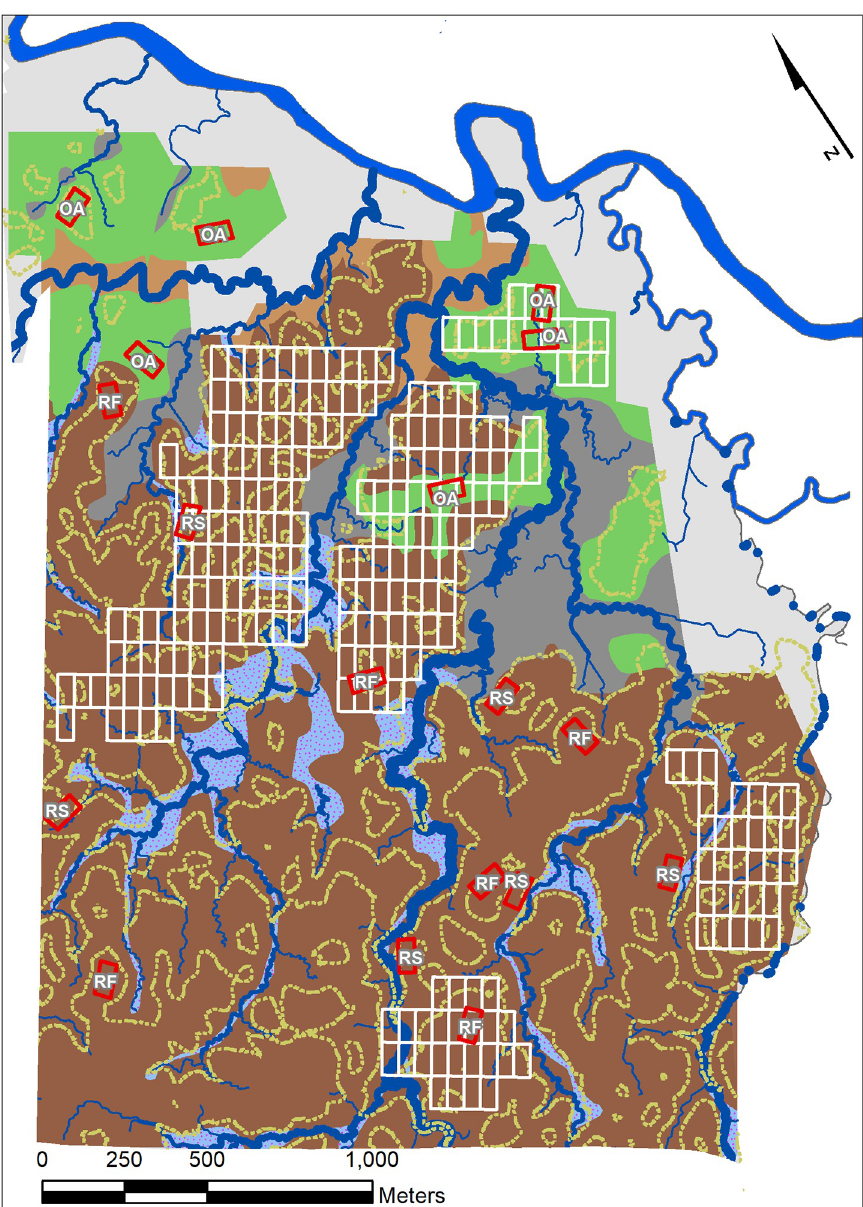
Fig 1. Study area. Soil types and study areas in old-growth tropical rain forest at the La Selva Biological Station, Costa Rica. Soil types [33] are residual (dark brown), old alluvial (green), swamp (gray), riparian (light gray stippled) and recent alluvium (light brown). 18 0.5 ha long-term inventory plots are show as red rectangles (RF = residual soil flat sites, RS = steeply-sloping residual soil, OA = flat old alluvial sites). White rectangles show the 238 0.50 ha plots with complete inventories of large